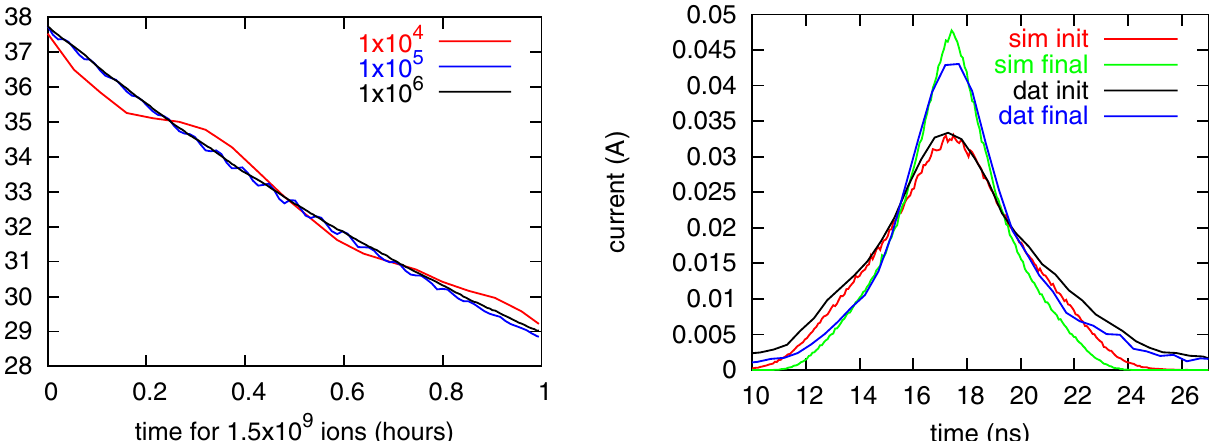
FIG. 8. (Color) Test of the scaling law over 2 orders of magni- tude. Equation (7) was used to relate the equivalent time for 1 : 5 (cid:8) 10 9 particles to the number of macroparticles used in the simulation.